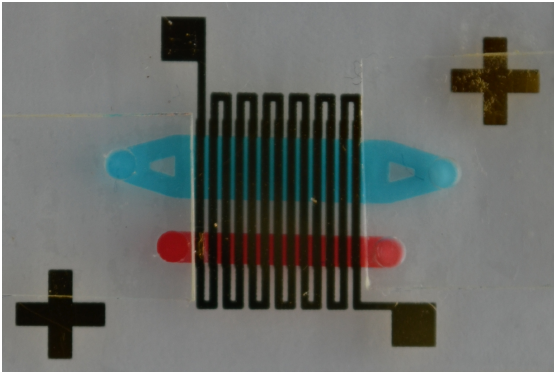
Figure 2. Close-up of the chip showing the Au resistive heater and alignment crosses, the DNA amplification chamber filled with blue food coloring dye, and the temperature monitor chamber filled with red food coloring